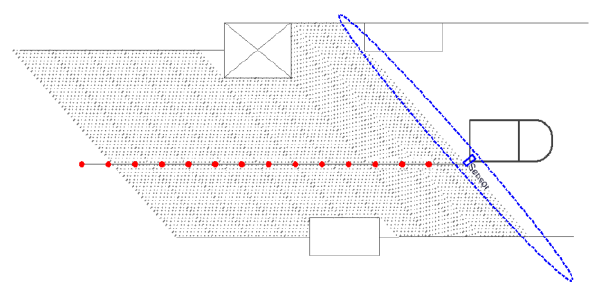
Figure 4. Trajectory points of the